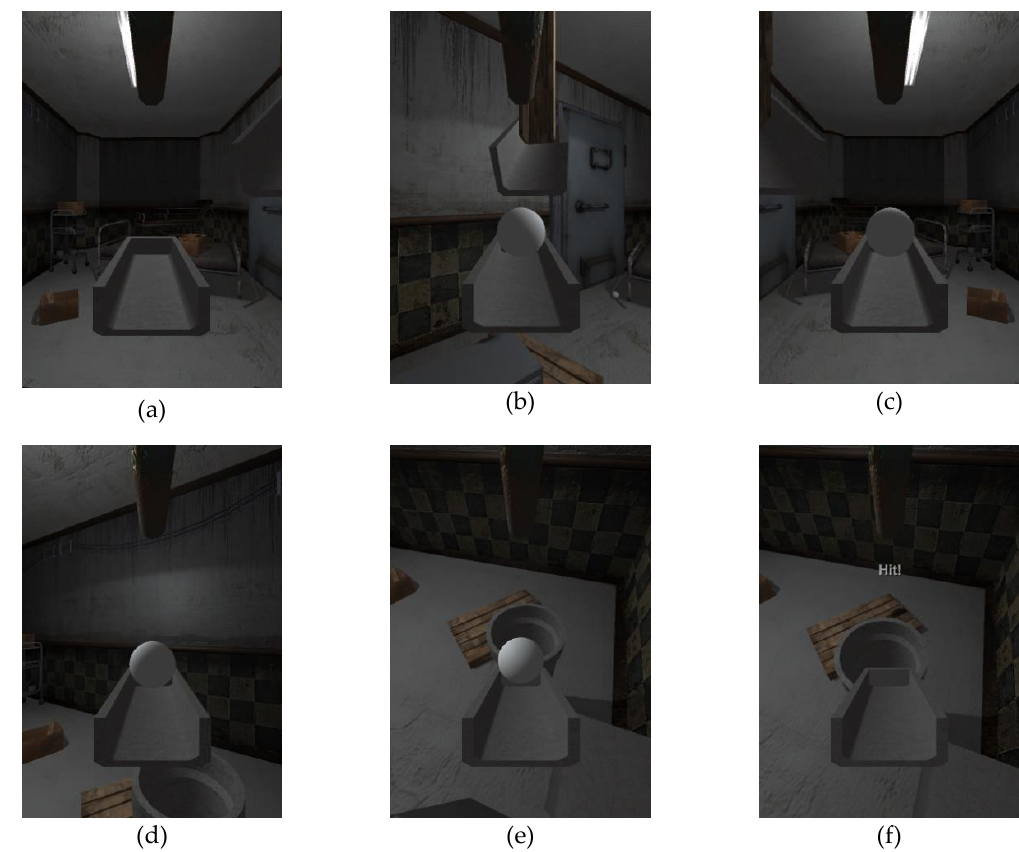
Figure 2. Screenshots from VR practice. ( a ) The player starts in a room. ( b ) The player turns left to receive a ball from the dispenser. ( c ) The player transfers the ball. ( d ) The player reaches the target container on the right. ( e ) The ball is placed into the target container. ( f ) When the ball enters the target container, the word “Hit!” is displayed.